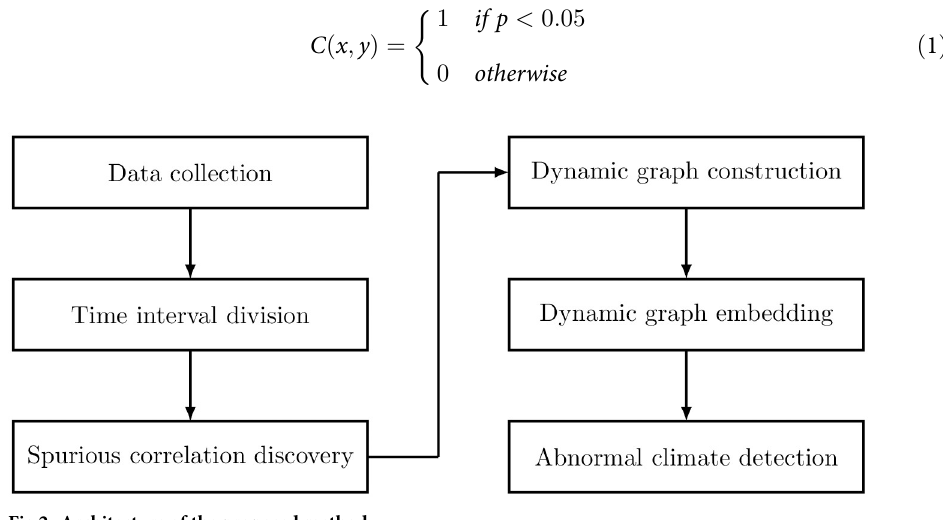
Fig 2. Architecture of the proposed